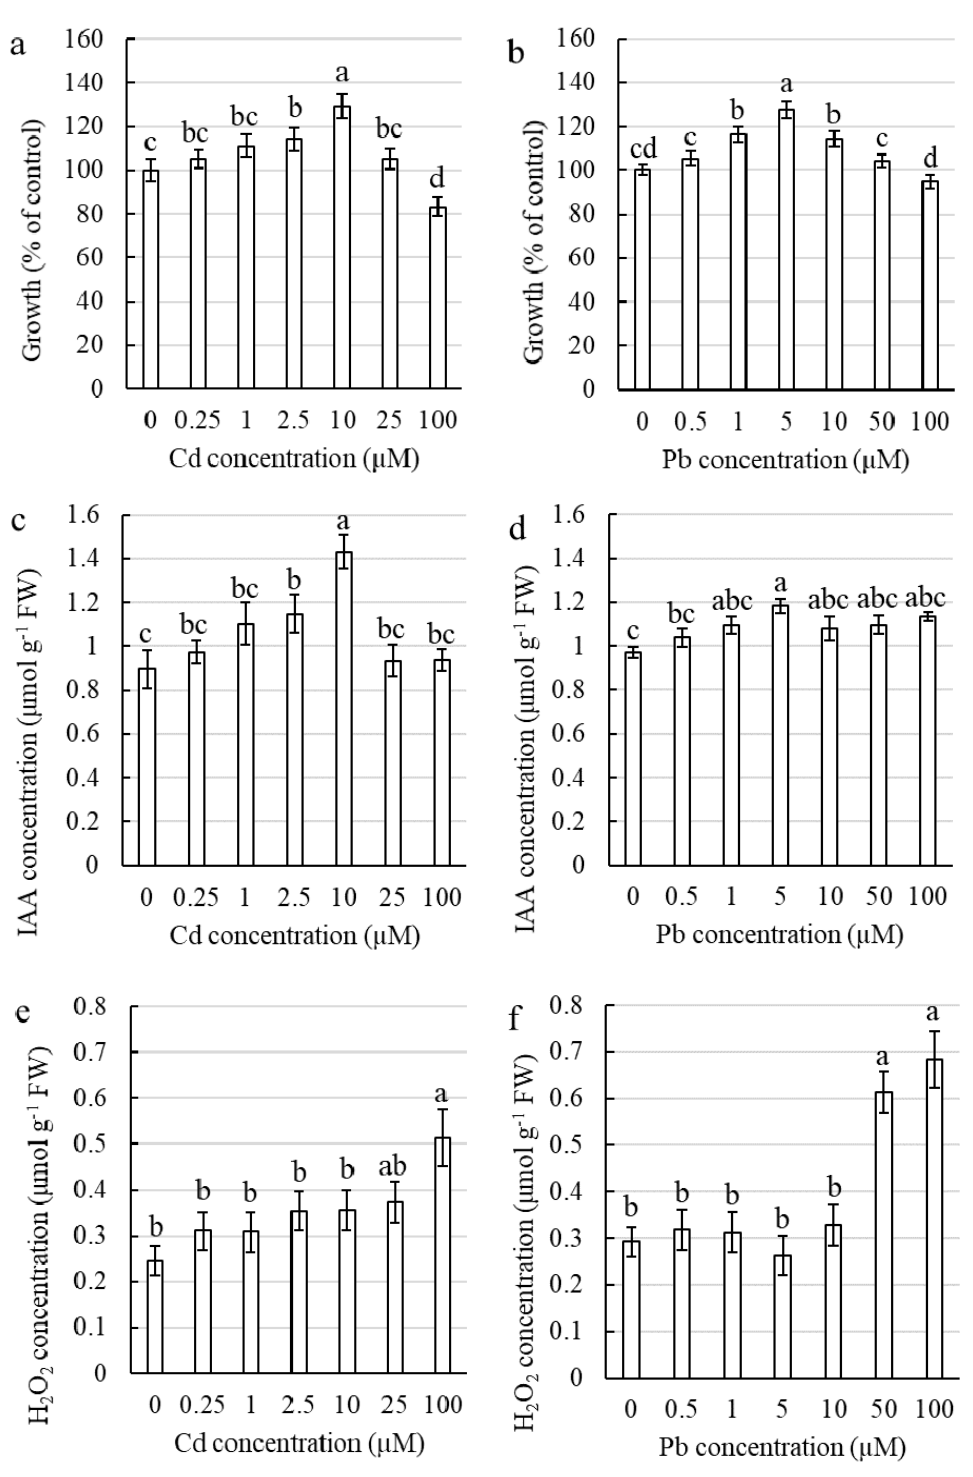
Figure 2. Physiological characteristics of the corn shoots treated with Cd or Pb for four days. Growth of shoots—( a ) Cd, ( b ) Pb; Auxin concentration in the leaves—( c ) Cd, ( d ) Pb; H 2 O 2 concentration in the leaves—( e ) Cd, ( f ) Pb. The values are the means ± SE ( n = 8, except for growth where n = 18). Means followed by the same letter are not significantly different from each other using the LSD test ( p < 0.05).